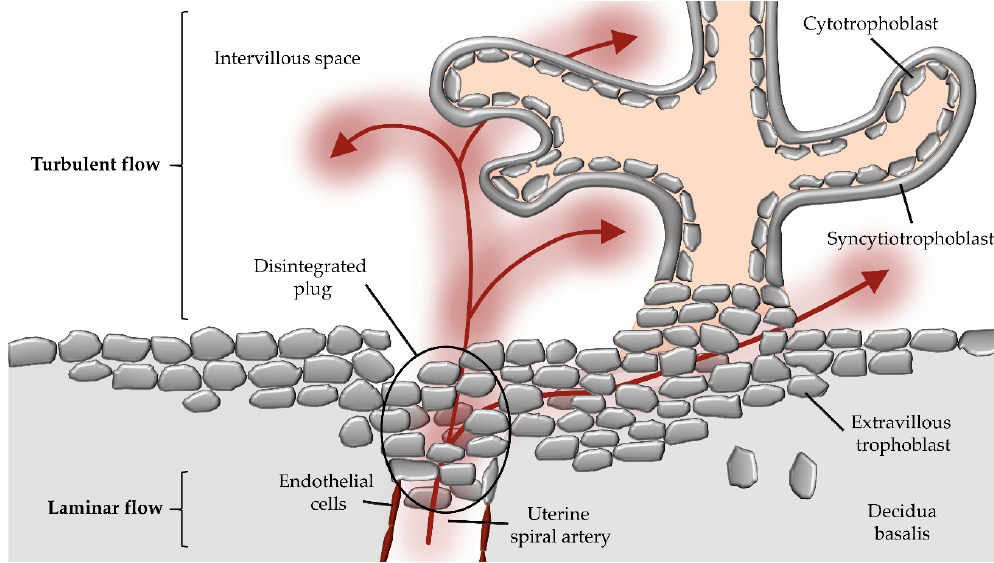
Figure 1. Potential route of maternal blood flow into the intervillous space during first trimester. During early placental development, maternal blood flow in maternal uterine spiral arteries is obstructed by extravillous trophoblast plugs. However, parts of maternal blood (red arrows) can pass through narrow intertrophoblastic gaps when trophoblast plugs begin to dissolve during first trimester of gestation. The laminar blood flow from the maternal spiral artery changes to a turbulent flow upon entrance into the intervillous space.